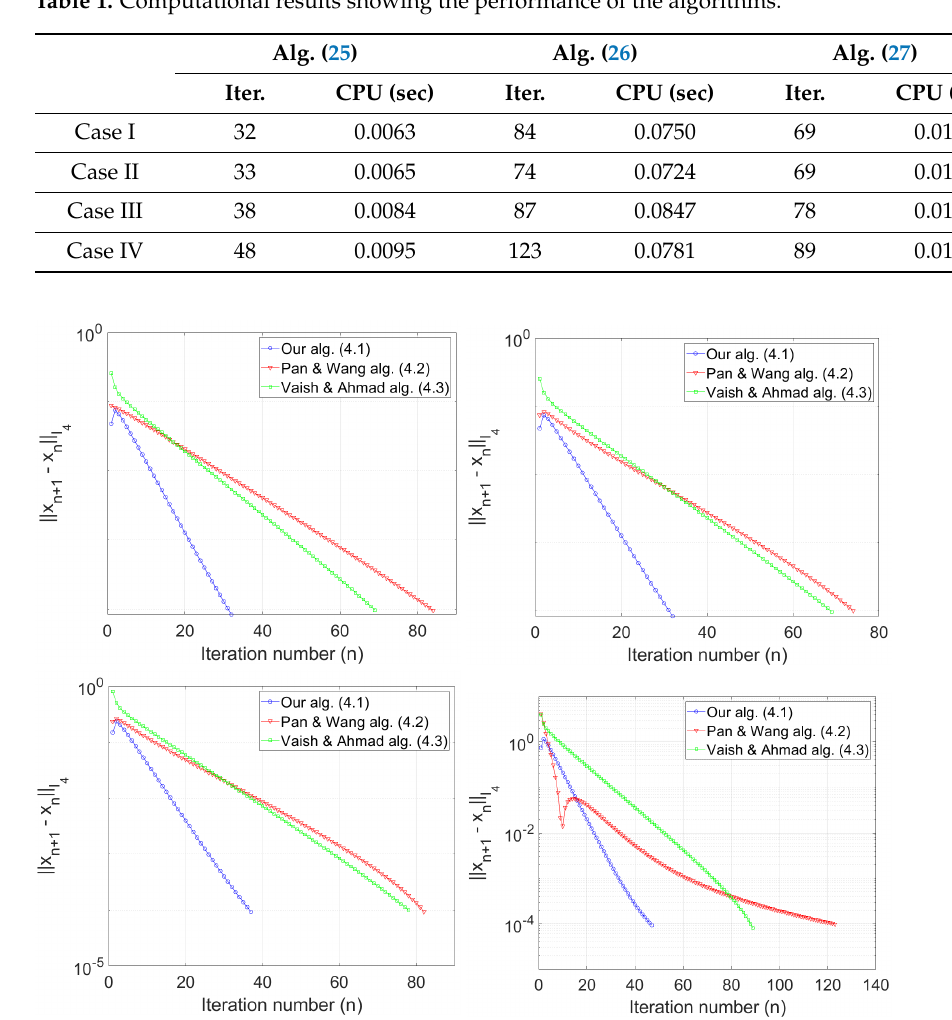
Table 1. Computational results showing the performance of the algorithms.